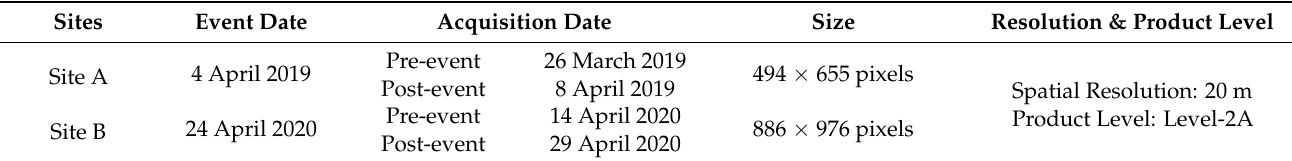
Table 1. Description of satellite image